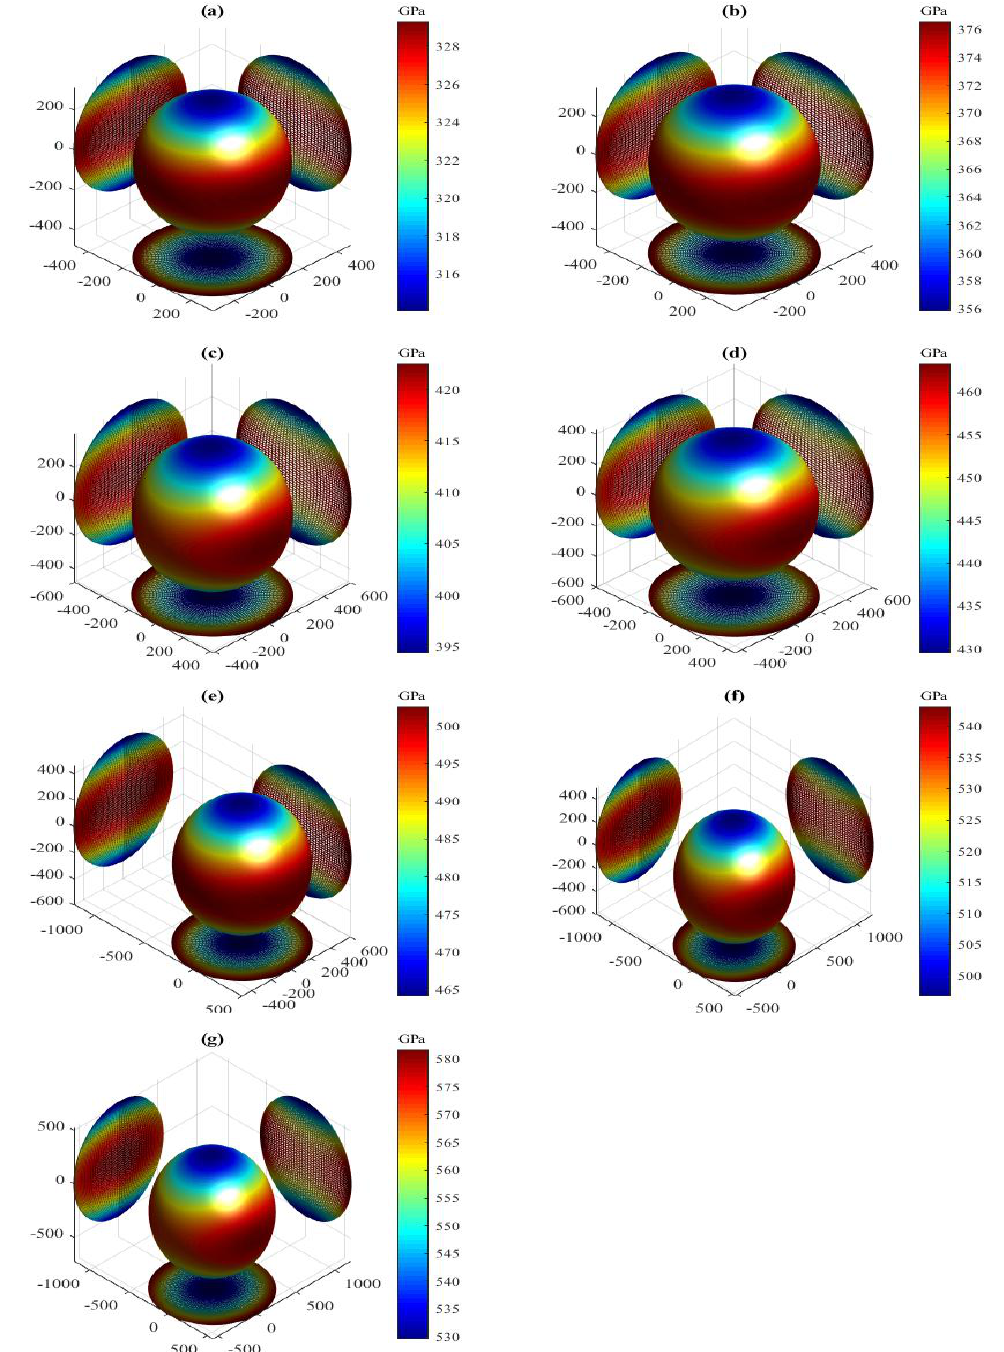
Figure 6. Directional dependence of bulk modulus for the LPS h-Al 2 Ti under pressure ( a ) 0